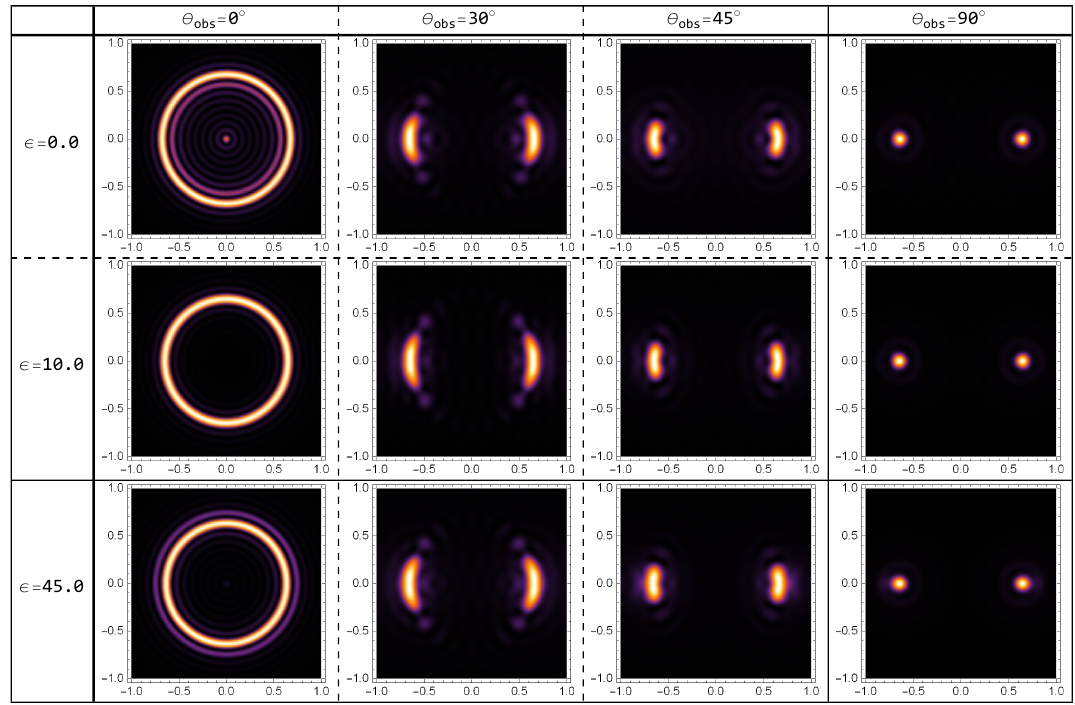
Figure 15 . The image for a scalar-mode perturbation. We calculate the image of a dissipation part of the response, where r h = 0 . 3 , ω = 80 , d = 0 . 5 , and σ = 0 . 01